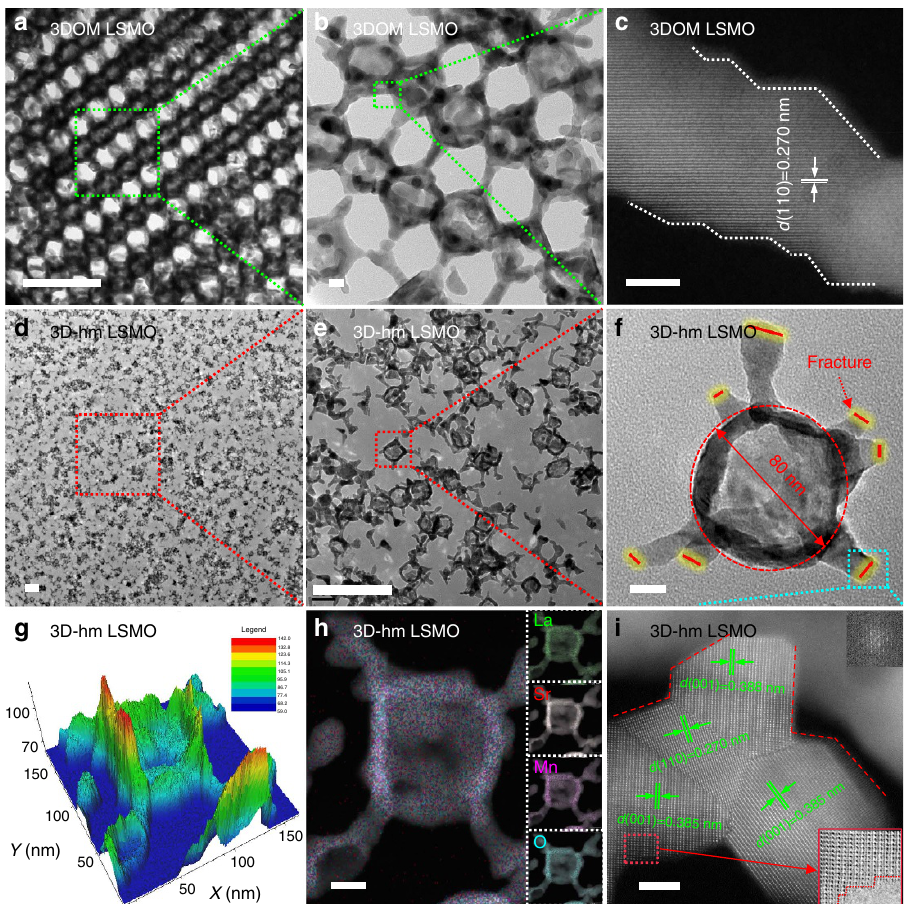
Figure 3 | FE-HRTEM analysis of LSMO catalysts. ( a , b ) FE-HRTEM images of 3DOM LSMO, ( c ) HAADF-STEM image of 3DOM LSMO, ( d – f ) FE-HRTEM images of 3D-hm LSMO, ( g ) 3D topography of 3D-hm LSMO extracted from ( h ) combined HAADF-STEM-EDS mapping of La, Sr, Mn and O with individual element mapping shown in the insets, and ( i ) HAADF-STEM image of the intersecting surface of the fractures in 3D-hm LSMO. Scale bars in a , d , e are 300nm. Scale bars in b , f , h are 20nm. Scale bars in c , i are